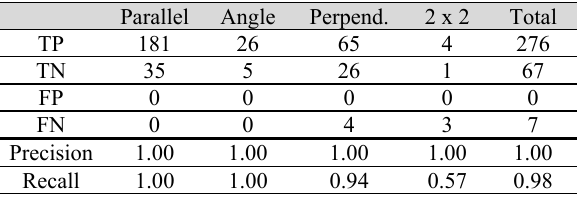
Table 6 . Results of repeated parking statistics conducted by Nebiker et al. (2021) using the newly trained object detector Part-A² Net anchor-free. Results are broken down by the type of parking space (parallel, angle, perpendicular and 2 x